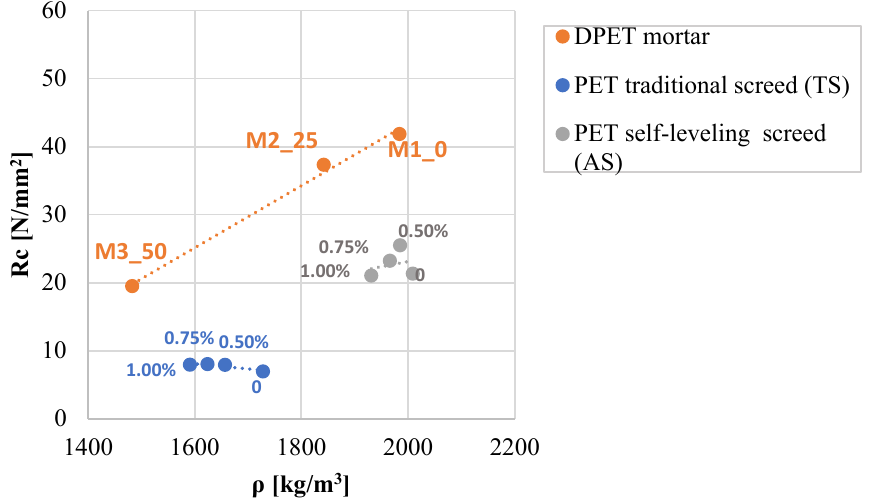
Figure 5. Compressive strength-specific weight relationship of the investigated materials: DPET mortars, PET traditional screeds, and PET self-leveling screeds.